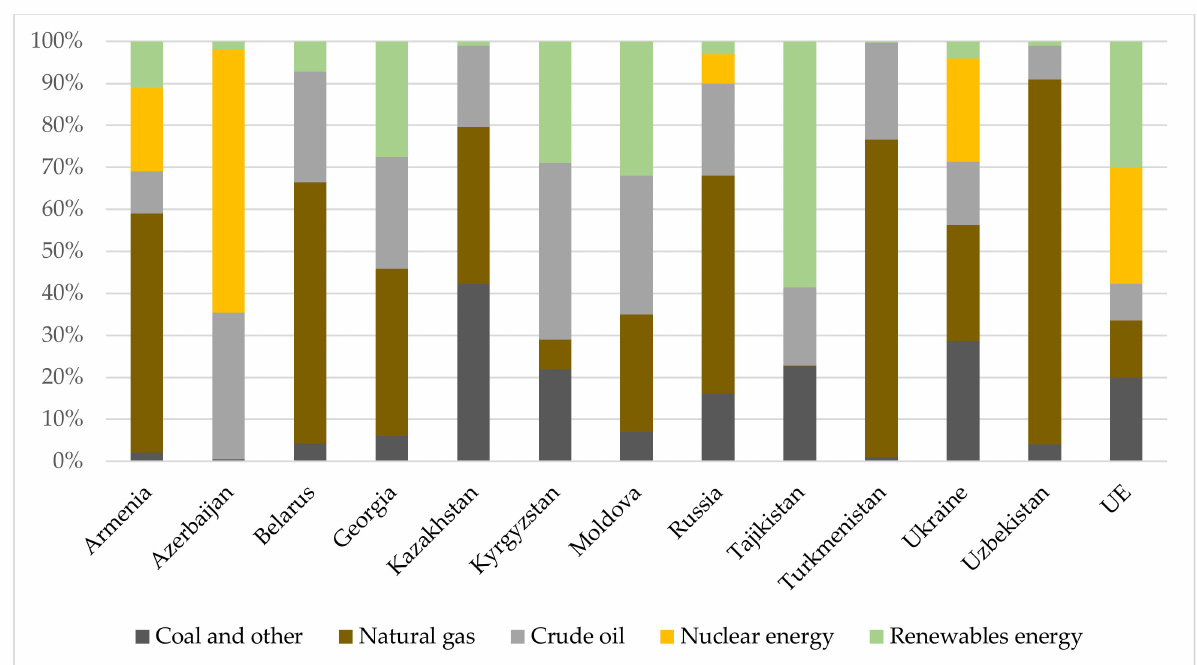
Figure 1. Structure of energy production sources in CIS and EU countries. Source: Own elaboration based on International Renewable Energy Agency (IRENA)